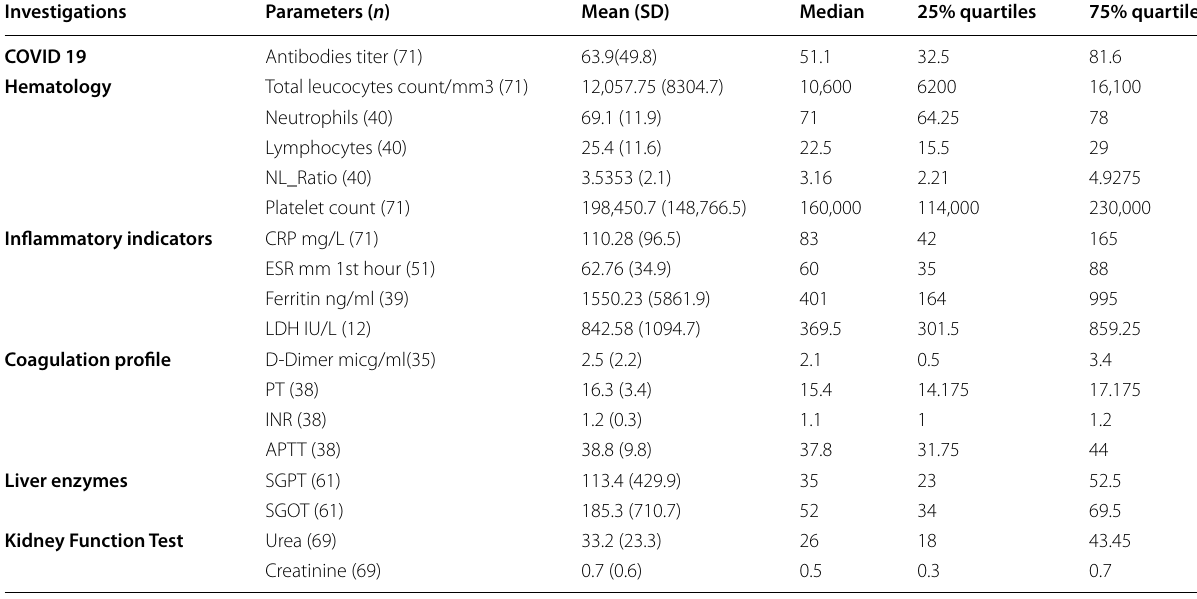
NL ratio Neutrophil–lymphocyte ratio, CRP C-reactive protein, ESR Erythrocyte sedimentation, LDH Lactate dehydrogenase, PT Prothrombin time, INR International normalized ratio, APTT Activated partial thromboplastin time, SGPT Serum glutamic pyruvic transaminas, SGOT Serum glutamic oxaloacetic transaminase